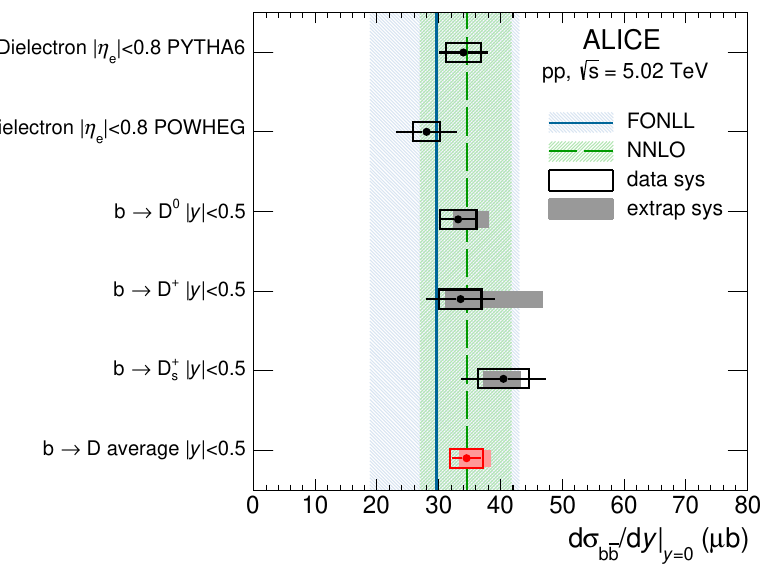
Figure 12 . Estimates of d σ / d y at midrapidity from dielectron [97] and non-prompt D 0 , D + , bb √ and D + meson measured in pp collisions at s = 5 . 02 TeV compared to FONLL [56, 57, 79] and s NNLO [65] predictions. The average d σ / d y of the estimates from the single D-meson species is bb also reported.